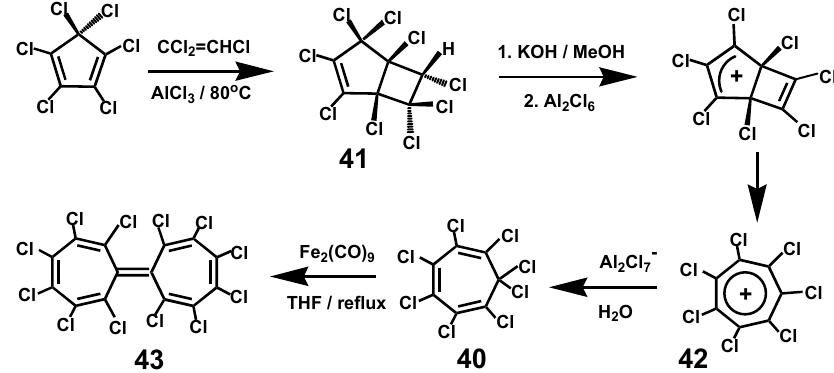
Scheme 16. Synthesis of octachlorocycloheptatriene.